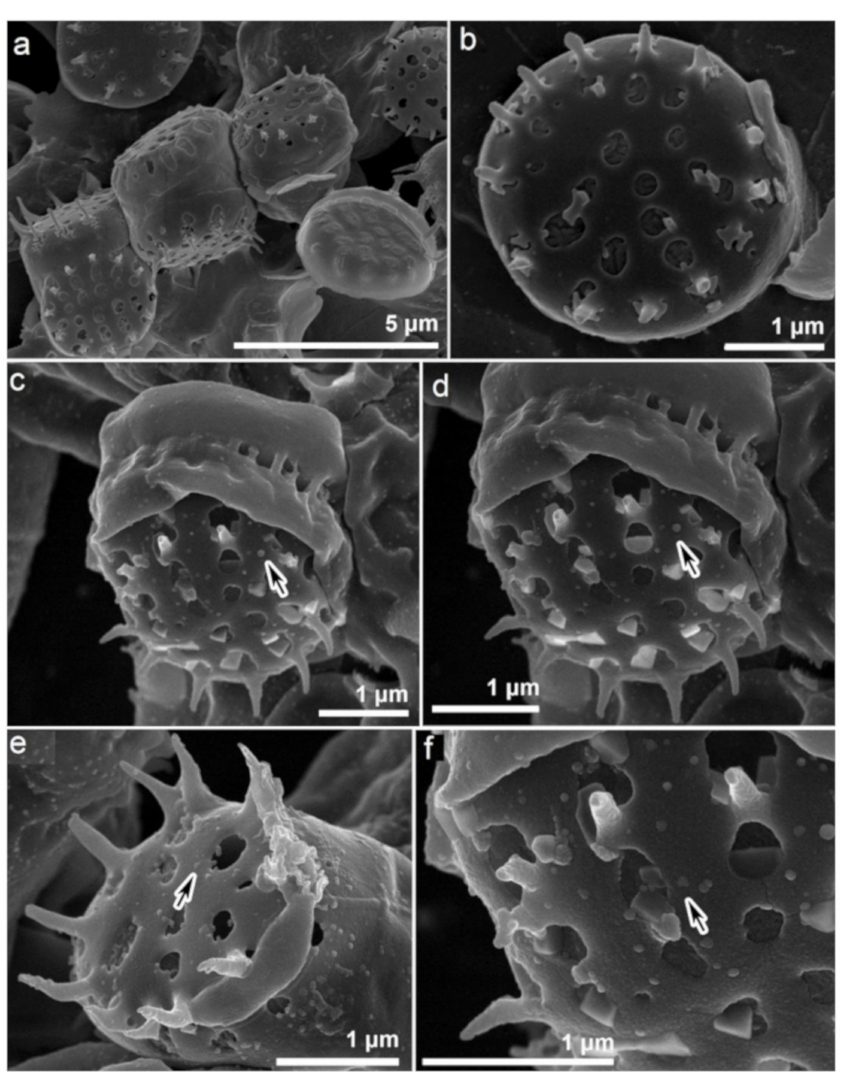
Figure 2. SEM images showing smooth surface topography of control cells of N. shiloi ( a , b ) and deposition of GNPs on Au 3+ -treated diatom cell surface ( c – f ). Arrows showing the formation of spherical ( c , d ) and triangular ( e , f )